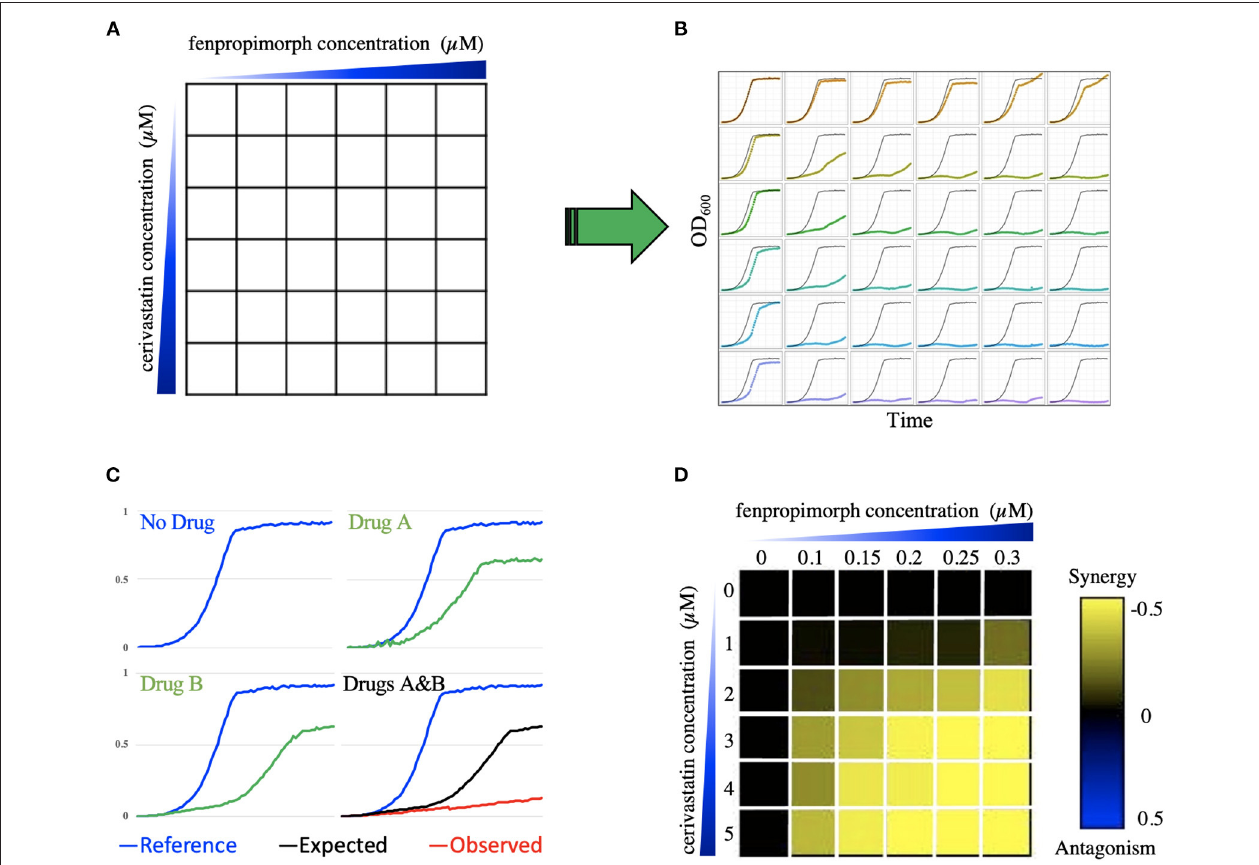
FIGURE 1 | Combination screening and transformation of growth data into a quantitative metric. (A) Illustrates the combination of compounds cerivastatin and fenpropimorph as an example. A 6-by-6 dose matrix is screened with an increase of each drug along the x and y axes. The blue triangles represent increasing concentration of drugs. In (B) each square in the 6-by-6 matrix is represented by a growth curve for each drug combination, which is optical density (OD 600 ) vs. time. Panel (C) shows an example of greater than additive inhibition due to synergy. The blue growth curves represent the DMSO (no drug) control. Green curves show growth in the presence of compounds A and B. The combination of A and B is shown in the bottom right-hand cell in which the black line indicates the expected growth rate based on the multiplicative model, while the red curve is the actual cell growth in the drug combination. In the heatmap (D) , the color of each square reports the epsilon value generated using the multiplicative model, where black represents no interaction, yellow represents synergy, and blue represents antagonism. In this heatmap, the 6-by-6 dose response matrix of cerivastatin vs. fenpropimorph provides an example of synergy, because epsilon is negative (yellow). W AB represents the relative growth of yeast in the presence of both drug A (cerivastatin) and drug B (fenpropimorph) when compared to a no-drug control (DMSO), W A represents the relative growth of yeast in the presence of drug A when compared to a no drug control. The color-coded scale bar from yellow (synergy) to blue (antagonism) covers the spectrum where W ab < W a × W b , to no interaction W ab = W a × W b to antagonism W ab > W a × W b